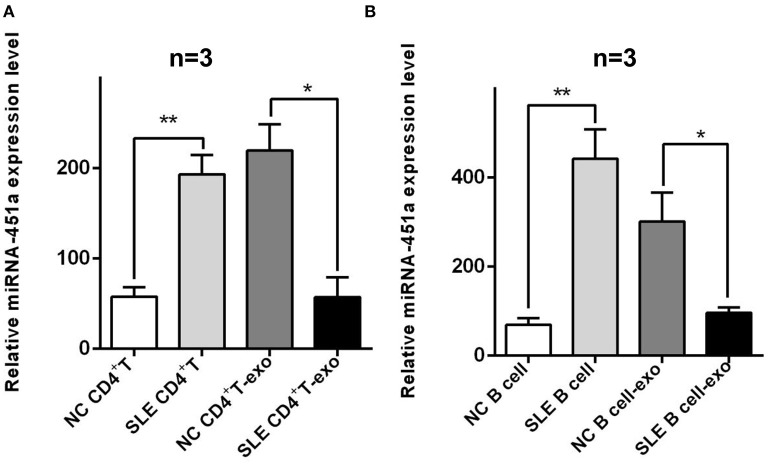
Differences verification of miR-451a expression in lymphocytes and lymphocytes derived exosomes. (A) The expression of miR-451a in CD4+ T cells of patients with SLE was significantly increased compared with that in normal CD4+ T cells, while the expression of T cells derived-exosomal miR-451a in patients with SLE was lower than that in normal controls (n = 3). (B) The expression of miR-451a in B cells or B cells derived-exosomes of SLE patients and normal controls showed the same trend (n = 3). *P < 0.05, **P < 0.01.